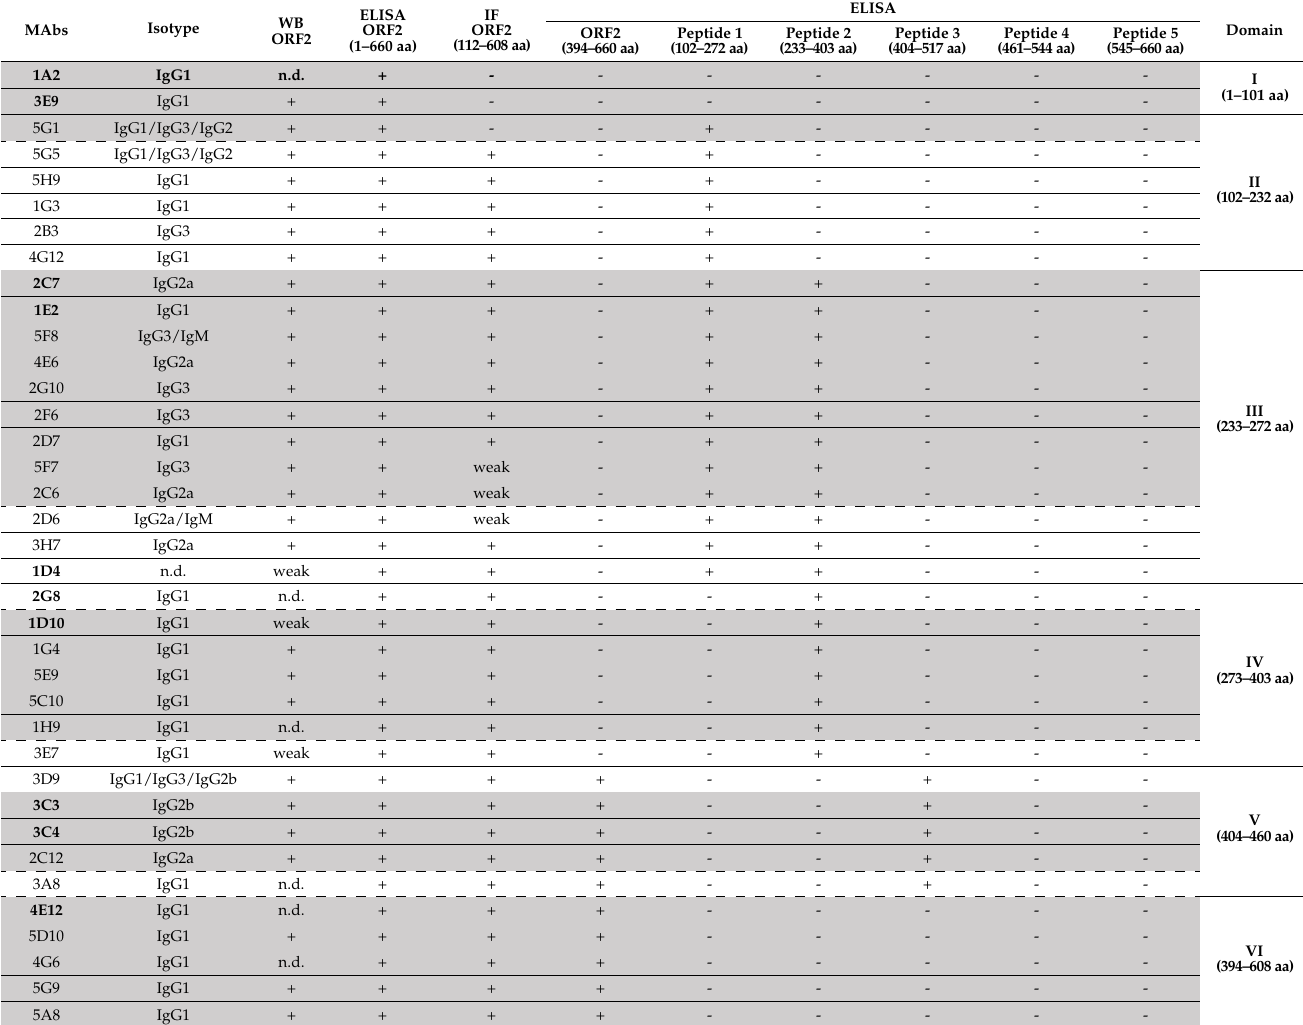
Table 1. List and features of the monoclonal antibodies produced. The response of each MAbs to different portions of protein in western blotting. Immunofluorescence and ELISA is indicated by +, weak, and -; n.d. is defined as no-detected. Cloned MAbs are shown in bold. Lines colored in grey and encircled by the dashed line represent antibodies that were reciprocally reactive in competitive ELISA. A total of six immune domains were identified on ORF2 based on MAbs